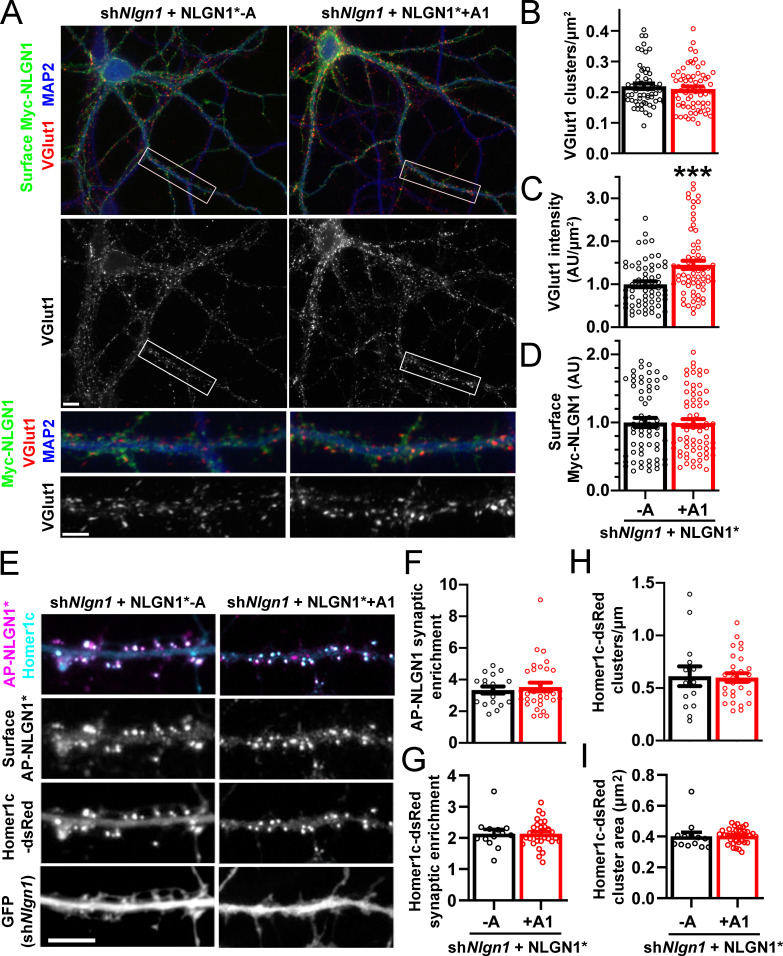
The NLGN1 A1 splice insert promotes structural synapse development.(A–D) Cultured hippocampal neurons were transfected with U6-shNlgn1-hSyn-CFP and hSyn-Myc-NLGN1* -A or +A1 at DIV 5 and neurons were fixed at DIV 12. The density of VGlut1 clusters did not differ but the total fluorescence intensity of VGlut1 inputs was higher for neurons expressing the NLGN1* +A1 than the -A isoform, ***p=0.0006 by Mann Whitney test, n = 59–66 neurons from three independent experiments. Cells were chosen for equal intensity of surface Myc-NLGN1. Scale bar, top 10 µm, bottom 5 µm. (E–I) Cultured hippocampal neurons were electroporated at plating with shNlgn1-GFP, Homer1c-dsRed, BirAER, and hSyn-AP-NLGN1* -A or +A1 and neurons imaged at DIV 14 following live cell labeling with streptavidin-Alexa647. The synaptic enrichment of AP-NLGN1*, defined as the intensity of AP-NLGN1* in Homer1c-dsRed-positive clusters relative to the intensity in the local dendrite shaft, did not differ between the splice variants, nor was there any difference in the synaptic enrichment or density or mean area of Homer1c-dsRed clusters (all p>0.1 by Mann Whitney test, n > 14 neurons from two independent experiments). Scale bar, 10 µm.